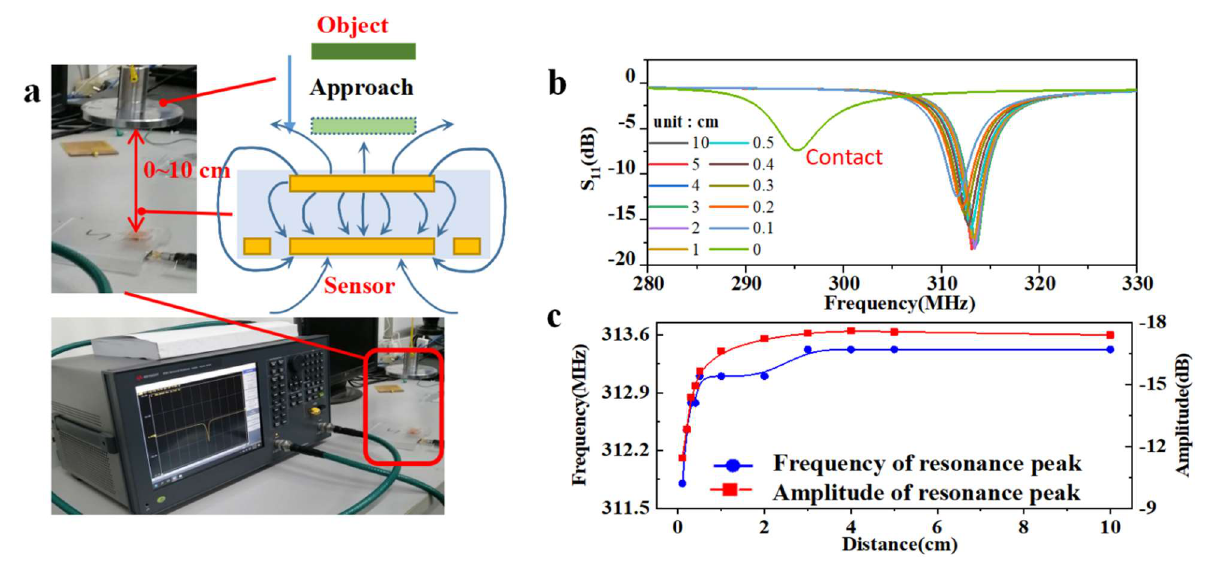
Figure 6. The non-contact sensing ability of the RF sensor. ( a ) Photos and schematic diagram of the non-contact sensing test. ( b ) Resonant frequency response curves at various distances. ( c ) Point curves of the frequency and amplitude of the S11 peaks.